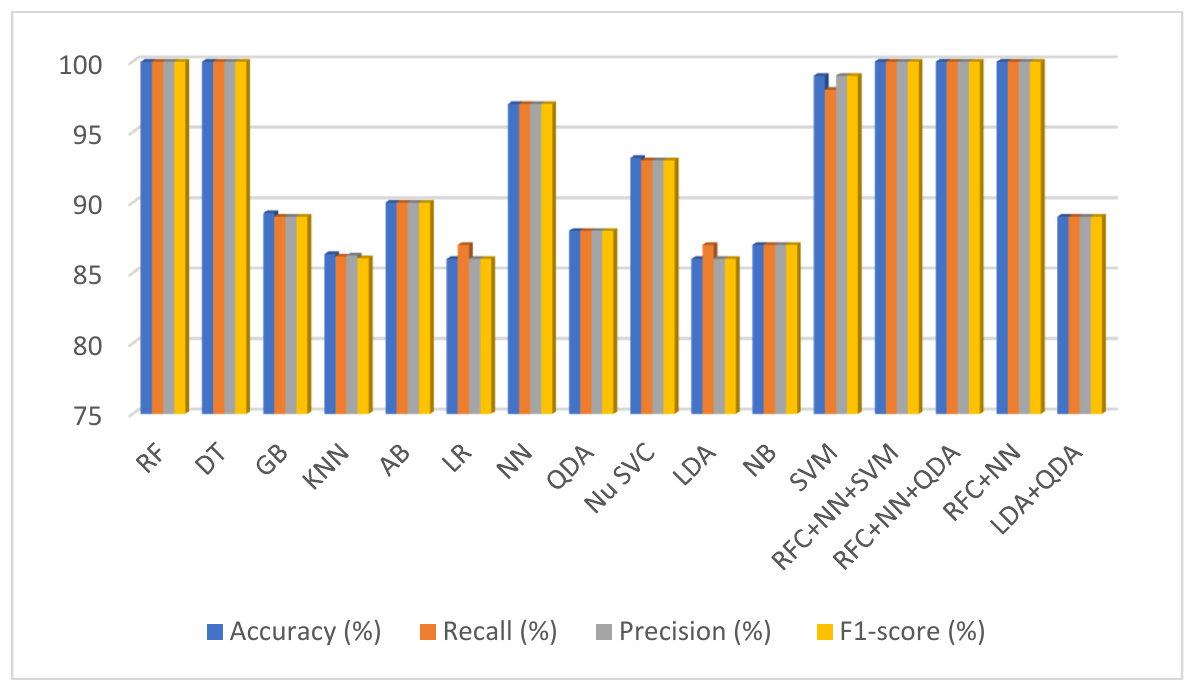
Figure 14. Performance of ML classifier using 5- fold cross-validation.